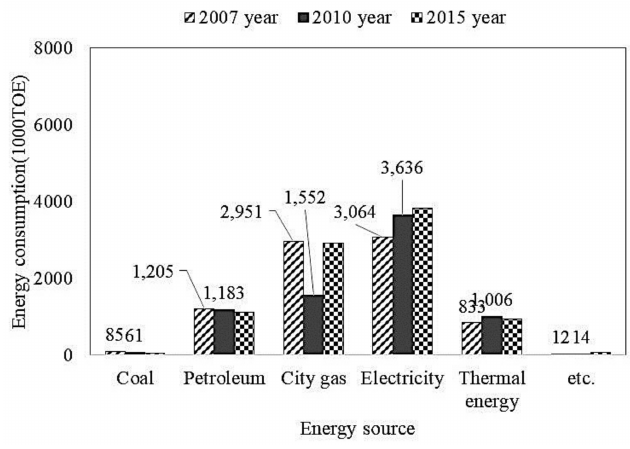
Figure 14. Energy consumption by buildings in Gyeonggi-do.